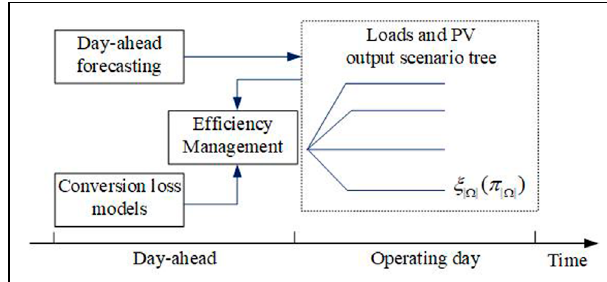
FIGURE 1 | Bidding process in the joint electricity and energy